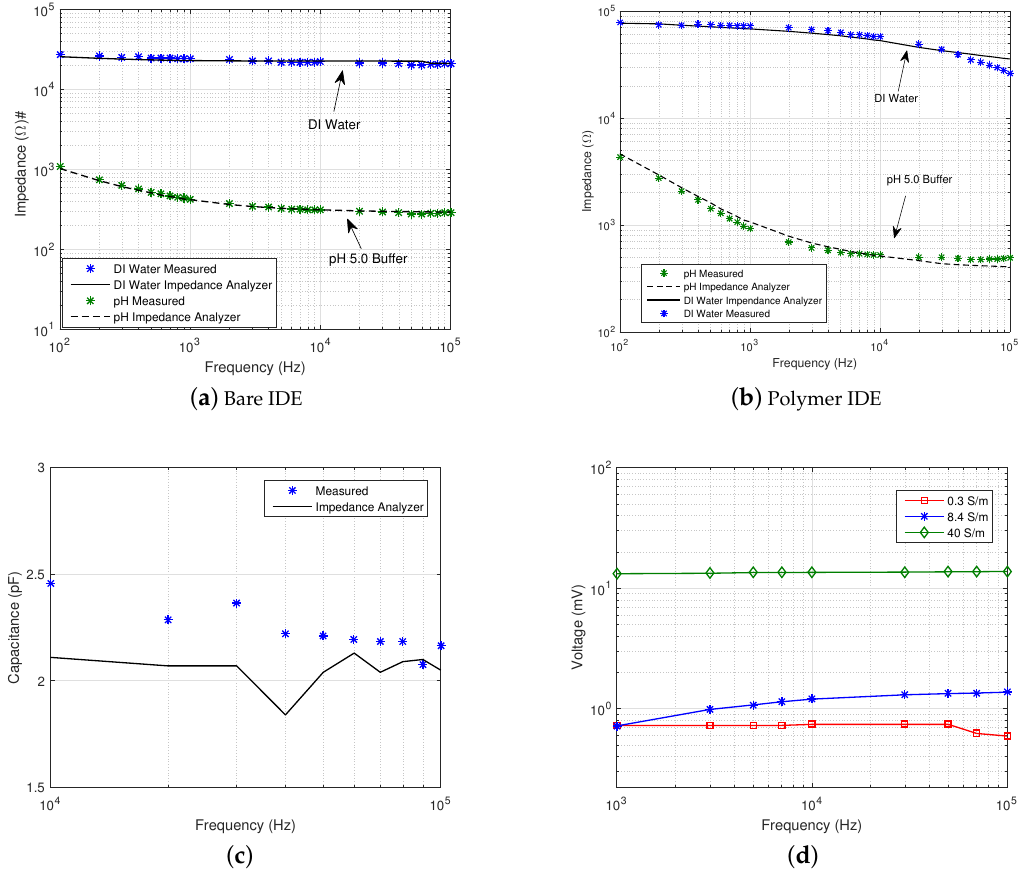
Figure 19. Impedance measurements. ( a ) Impedance of a bare IDE and ( b ) a polymer-coated IDE in DI water and pH 5.0 buffer solution; ( c ) capacitance of a dry IDE versus frequency and ( d ) tetrapolar voltage measurements in saline solutions of different